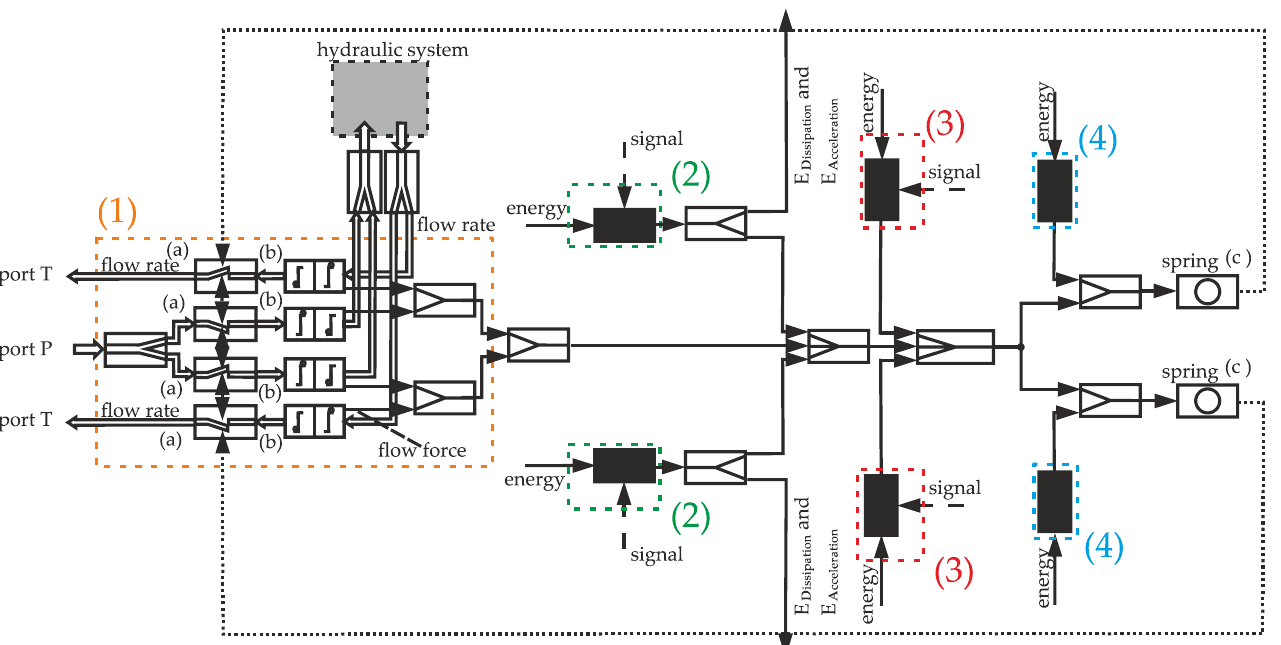
Figure 8. The extended function structure of “valve and its actuation